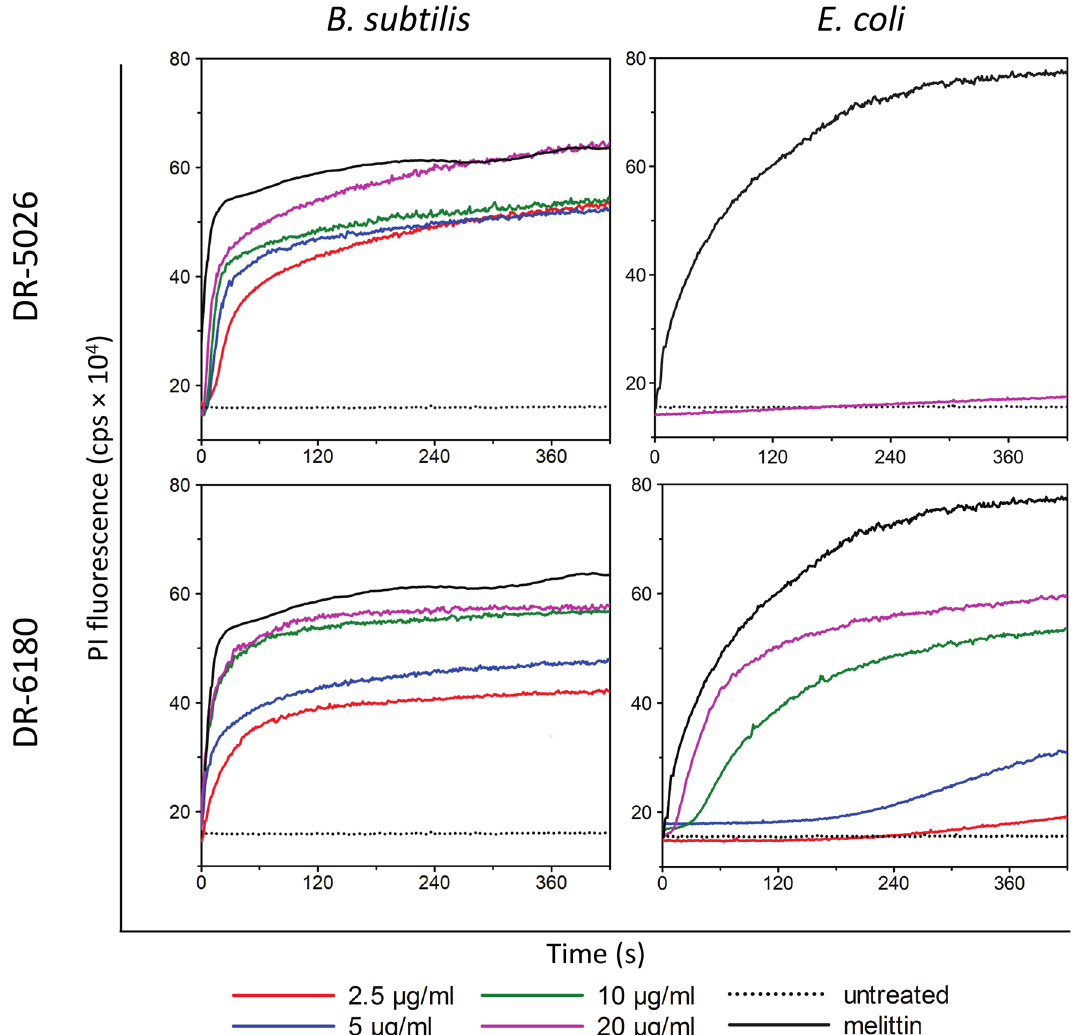
Figure 3. Permeabilization of B. subtilis and E. coli membrane induced by LPPO. Concentration dependence of LPPO I- (DR-5026) and LPPO II- (DR-6180) induced membrane permeabilization was measured as the increase in fluorescence intensity of the probe propidium iodide. The black dotted line (“untreated”) shows the fluorescence of PI in the suspension of cells without LPPO addition. Melittin at a concentration of 10 µM served as a positive control. Representative kinetics from at least three independent experiments performed in duplicate are shown. With the exception of B. subtilis exposed to 2.5 µg/ml DR-5026 the kinetics of PI entry correlated with growth inhibition of the tested bacteria in the presence of LPPOs (Supplementary Fig.